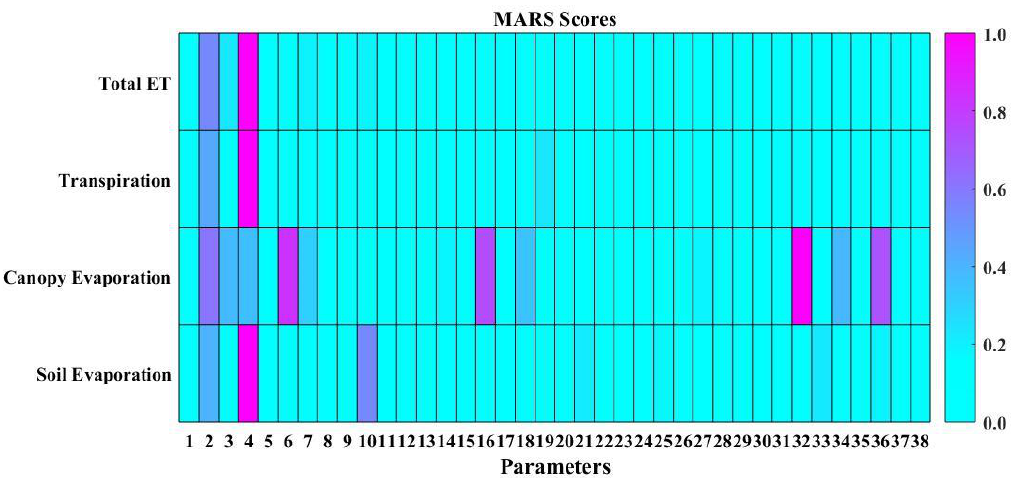
Figure 3. Normalized sensitivity scores of 38 parameters for total evapotranspiration and its three component simulations. MARS = multivariate adaptive regression spline method. Table 1. List of sensitive parameters for the evapotranspiration simulation in the Community Land Model version 4.0.